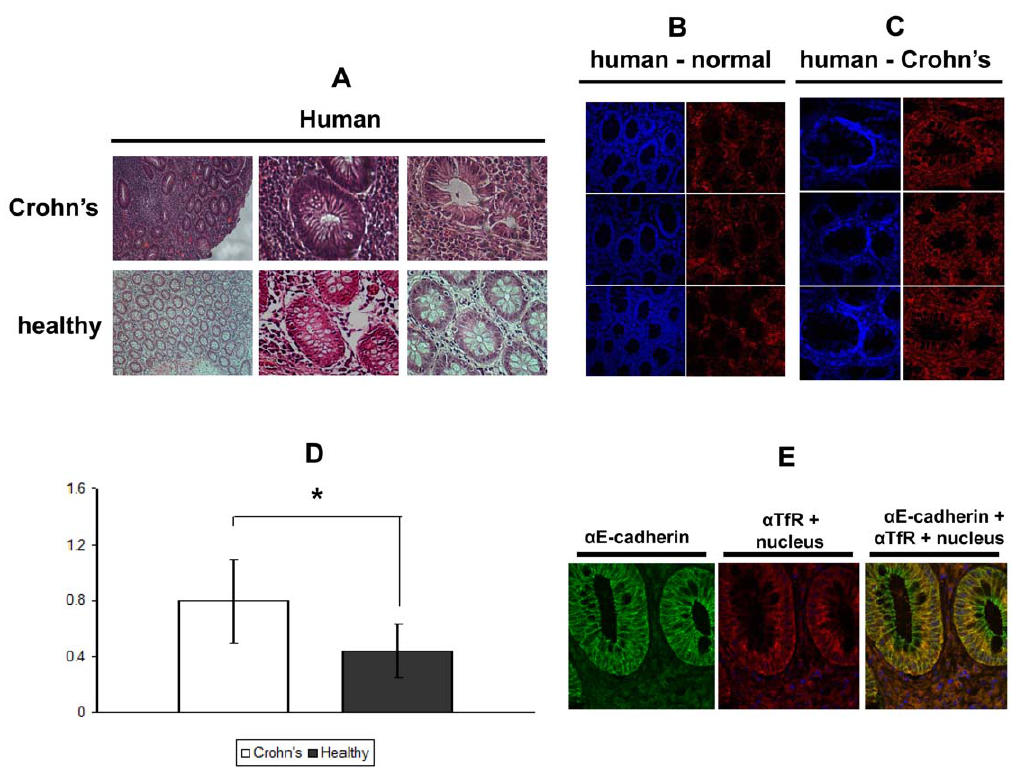
Figure 2. Enhanced expression of TfR in inflamed colonic epithelium in humans. (A) Typical hematoxylin and eosin staining of human biopsies taken from Crohn’s disease patients and patients with non-inflamed colonic mucosa.TfR immunostaining of transverse sections from human biopsies taken from non-inflamed colonic mucosa (B) and from lesions of Crohn’s disease patients (C). Left panels (of B and C): nucleus staining (blue). Right panels (of B and C): TfR staining (red). Magnification: 6 25; (D) Quantification of the fluorescence intensity (Image Pro Plus) in the specimens taken from the Crohn’s patients (N=9) and non-inflamed (‘‘normal’’) patients (N=12) is shown on the left; (E) Anti-E-cadherin (left panel, green) staining of inflamed tissue, staining of TfR (red) and nuclei (blue) (middle panel), merge (right panel).